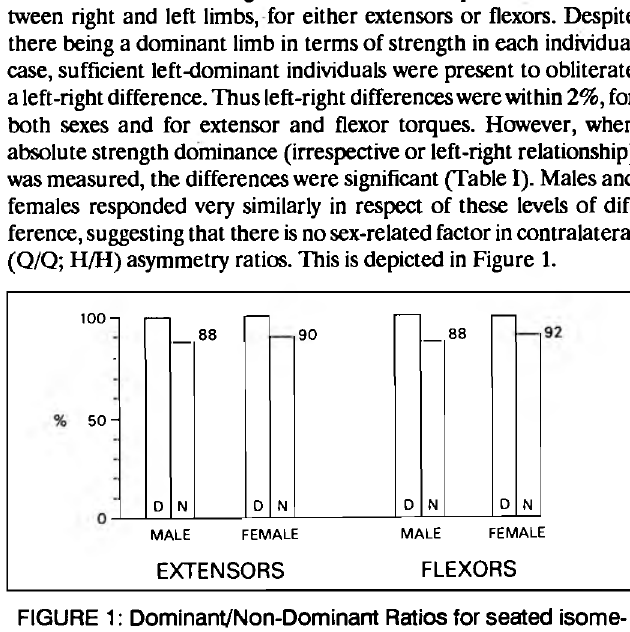
FIGURE 1: Dominant/Non-Dominant Ratios for seated isome­ tric knee extensor and flexor